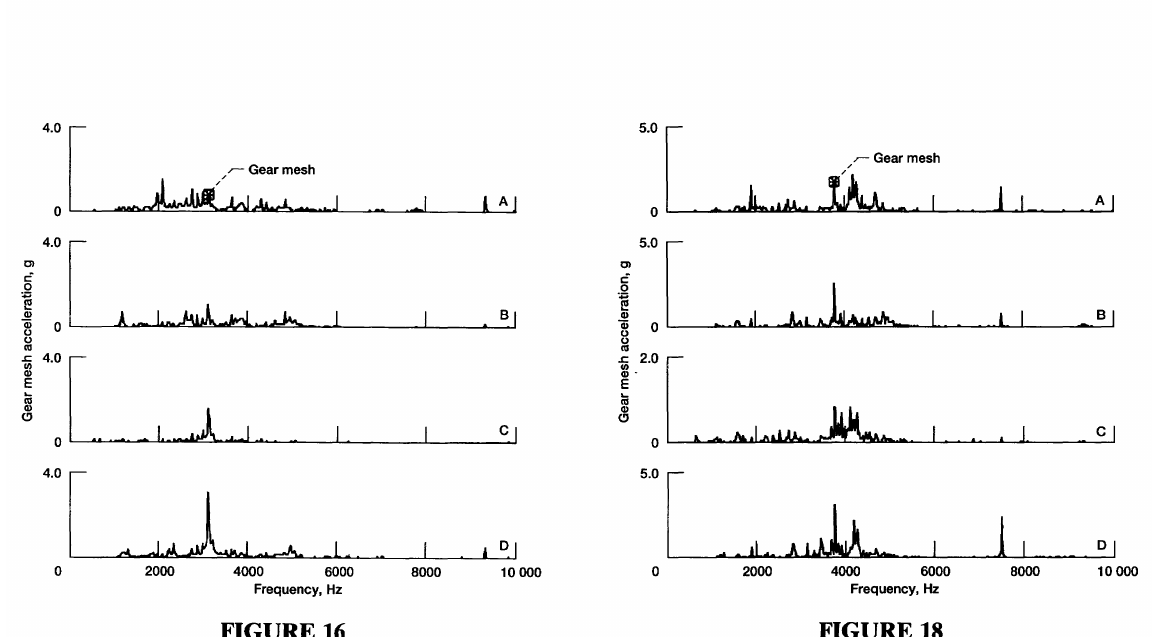
SUMMARY OF RESULTS Previous tests applied piezoelectric actuators to control rotor vibrations at low frequencies of 100-250 Hz. The results obtained in this study show that a piezoelectric actuator with a feed forward control can reduce the gear mesh vibra tion amplitude up to 75% for frequencies up to 4500 Hz. Experimental results showed a signifi cant reduction in gear mesh vibration at different speeds and torques. Future work will